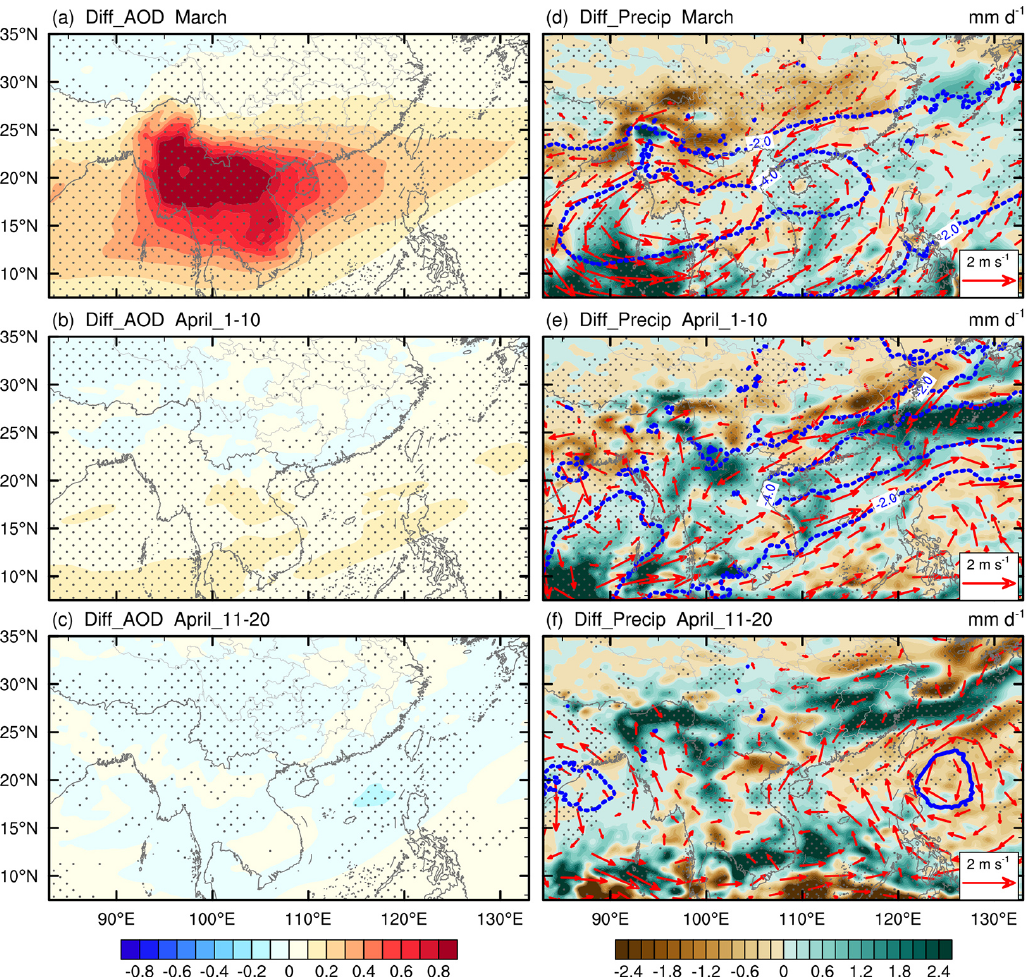
Figure 5. WRF-Chem-simulated ensemble-mean differences in (a–c) AOD (shading; unitless) and (d–f) precipitation (shading; mmd − 1 ), 850hPa wind (vector; ms − 1 ), and geopotential height (blue contours with an interval of 2dagpm; the dashed contours are for negative values and the zero contour is omitted for clarity) between CTRL and BBER (i.e., CTRL minus BBER) during (a, d) March, (b, e) early April, and (c, f) mid April of 2010. Stippling (red vector) denotes the AOD and precipitation (wind) that are statistically significant at the 95% confidence level based on a Student’s t